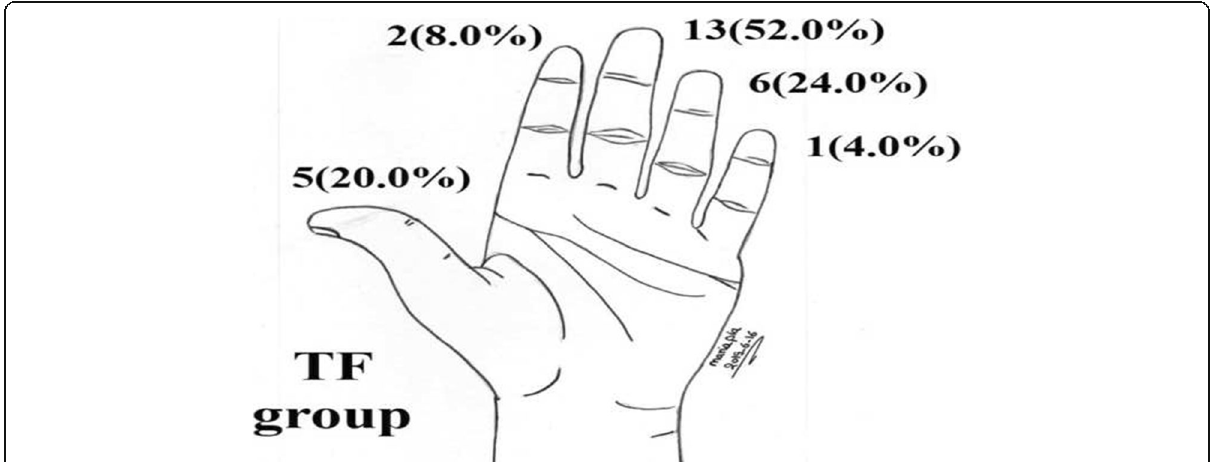
Fig. 8 Distribution of trigger fingers among different fingers in the hands of the trigger finger (TF) group ( n = 25 hands from 22 patients). There were two hands (8%) which had two fingers with TF in each hand from two different patients (9.1%). These two hands were mentioned twice. Subsequently, the counted number of the hands in the figure was 27 hands. These were as the following: (i) one hand had thumb TF and middle TF. It was mentioned twice (once with thumb TF and the other time with middle TF). (ii) One hand had middle TF and ring TF. It was mentioned twice (once with middle TF and the other time with ring TF). TF , trigger finger; number (percentage), number (percentage) of hands